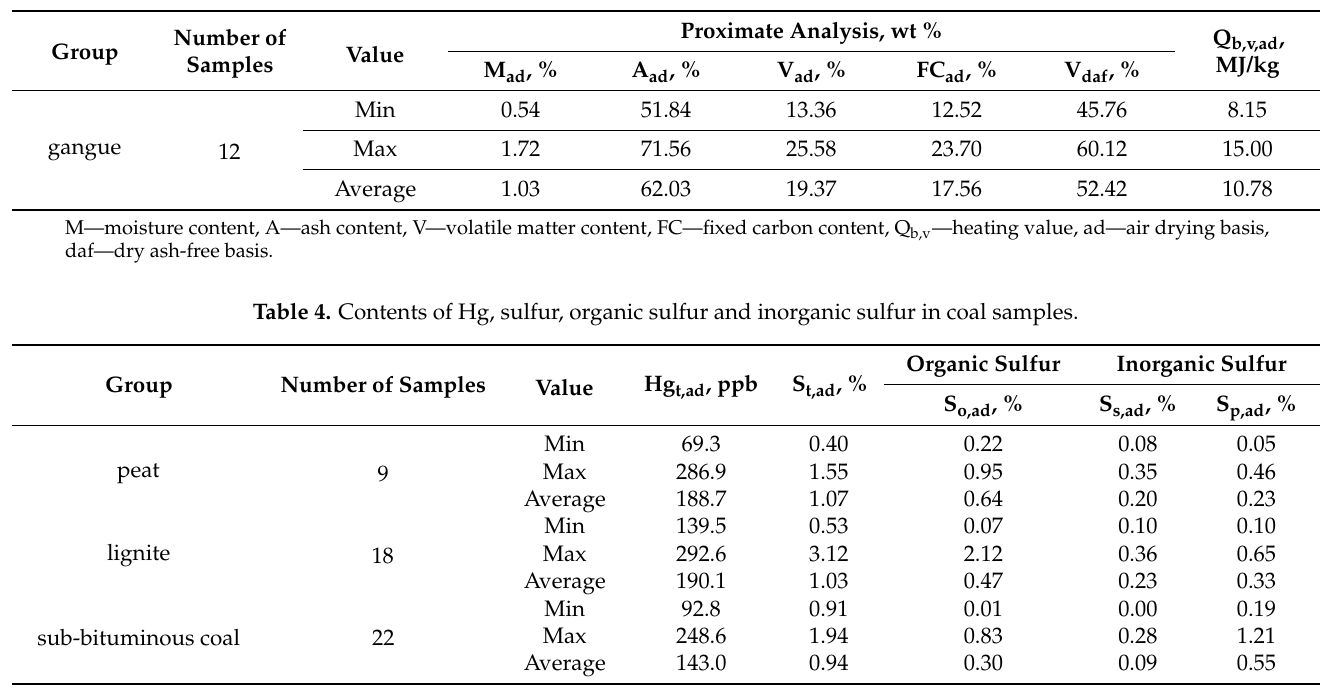
Table 3. Proximate analysis of the gangue samples.